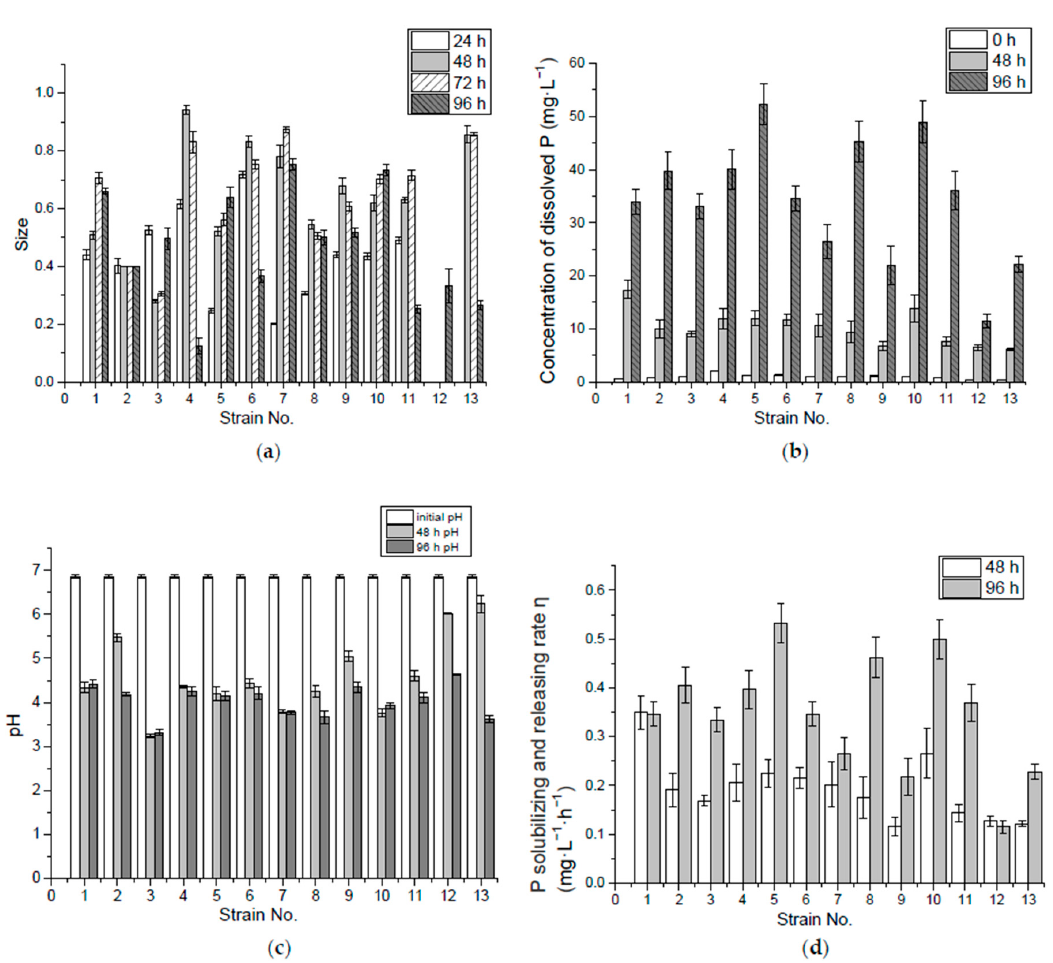
Figure 1. The size (2b/a) of the P solubilizing ring of 13 preliminary screened bacteria from Acorus calamus L. and Iris tectorum Maxim. ( a ); Concentration of dissolved P ( b ), pH ( c ) and P-solubilizing and -releasing rate ( d ) by 0 hour, 48 h, and 96 h in Ca 3 (PO 4 ) 2 liquid medium. Error bars represent the standard errors.